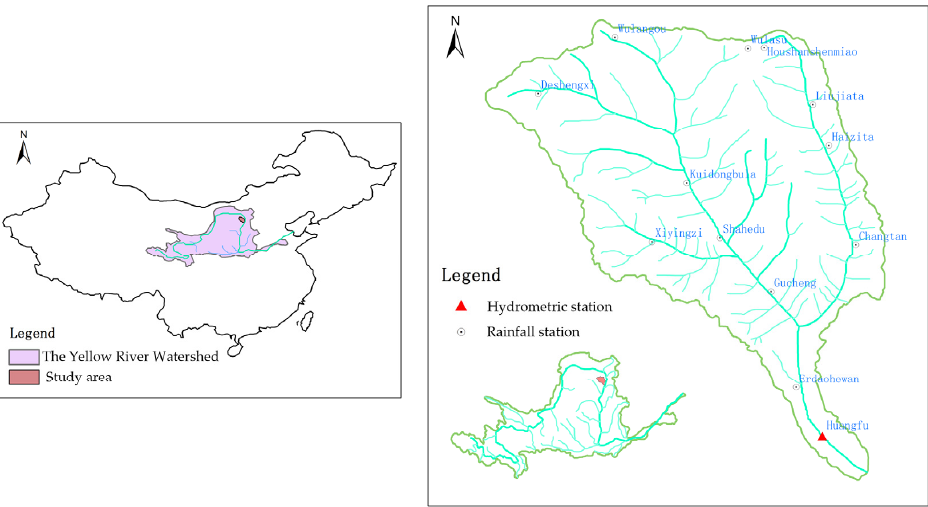
Figure 1. The location of the Huangfuchuan watershed.